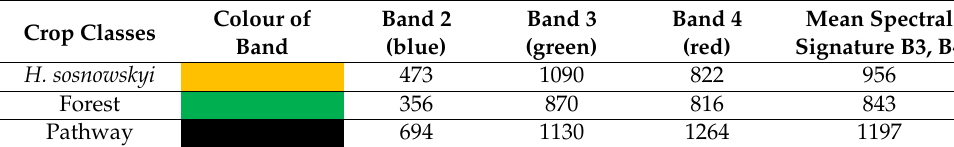
Table 1. Results for spectral